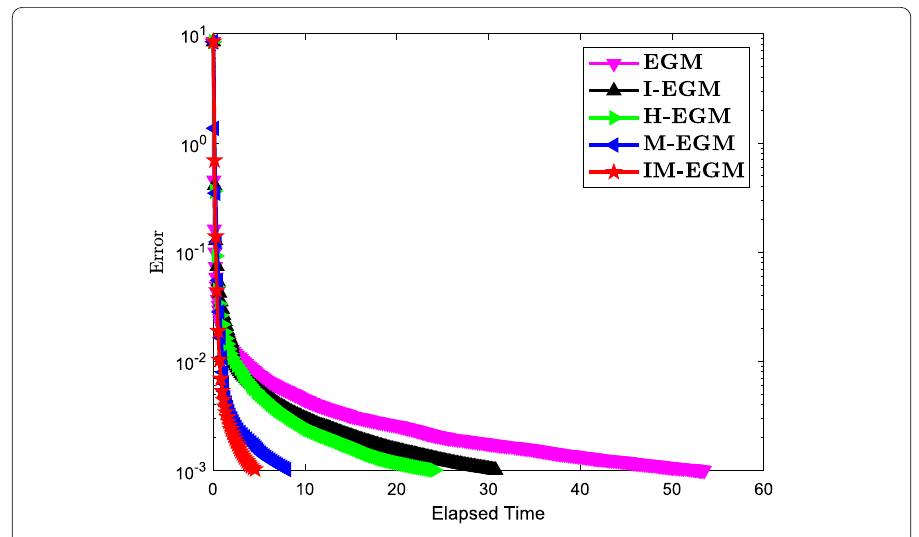
Figure 10 Numerical comparison of Algorithm 1 and Algorithm 2 using Algorithm 1 in [52], Algorithm 2 in [51], and Algorithm 1 in [18], while N = 50 for the error term 10